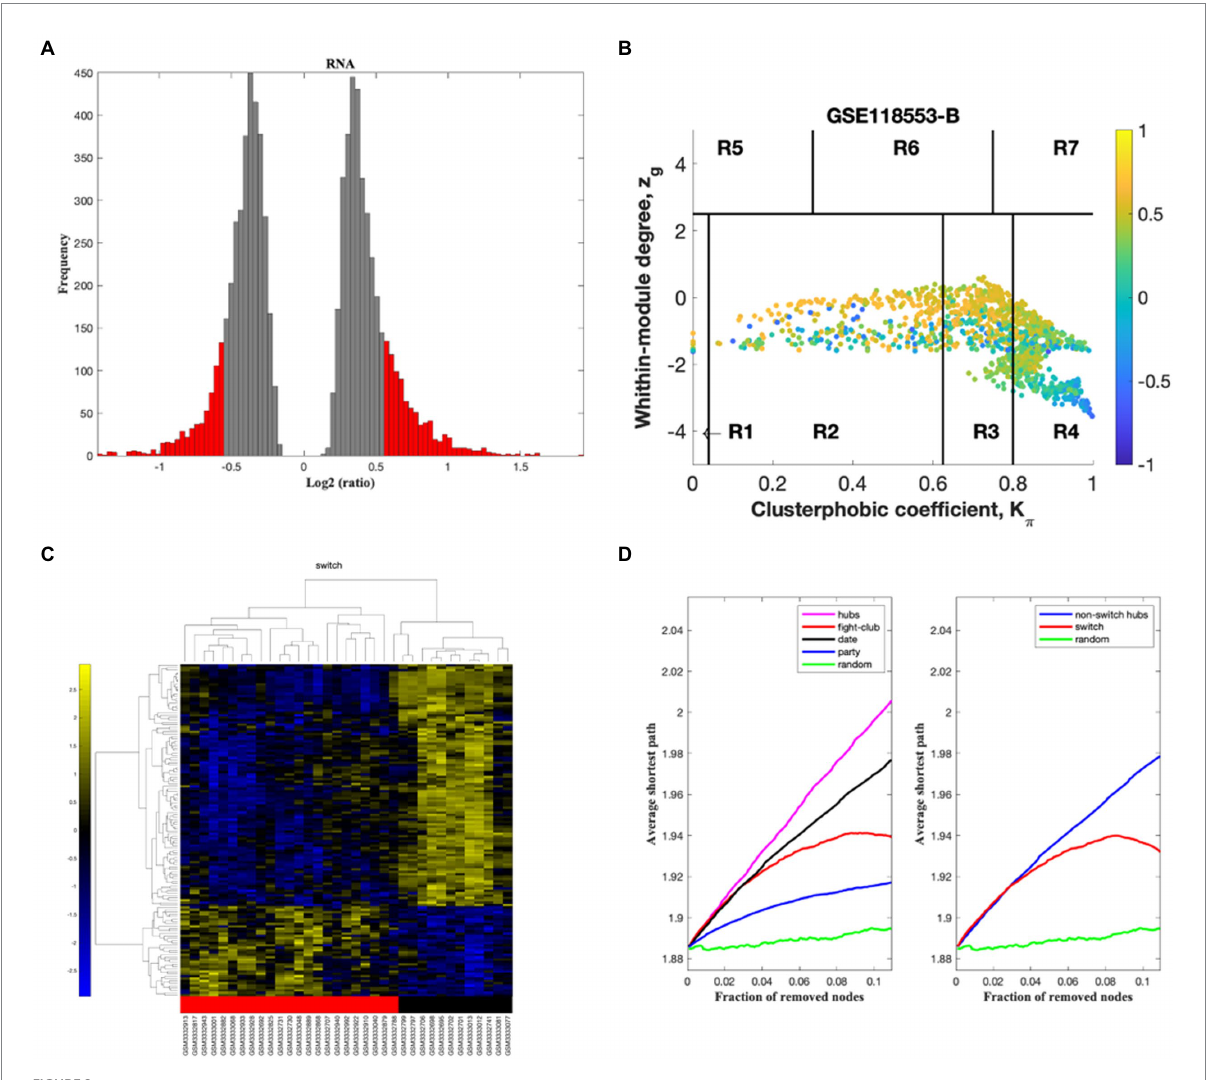
FIGURE 2 SWIM analysis of entorhinal cortex from female AD compared to normal control subjects in GSE118553. (A) Distribution of log2 fold change values where the red bars are selected for further analysis. (B) Heat Cartography Map with nodes colored by their average Pearson Correlation Coefficient. Region R4 represents the switch genes. (C) Dendrogram and heat map for switch genes. The red markers indicate that the sample came from the diseased cohort. (D) Robustness of the correlation